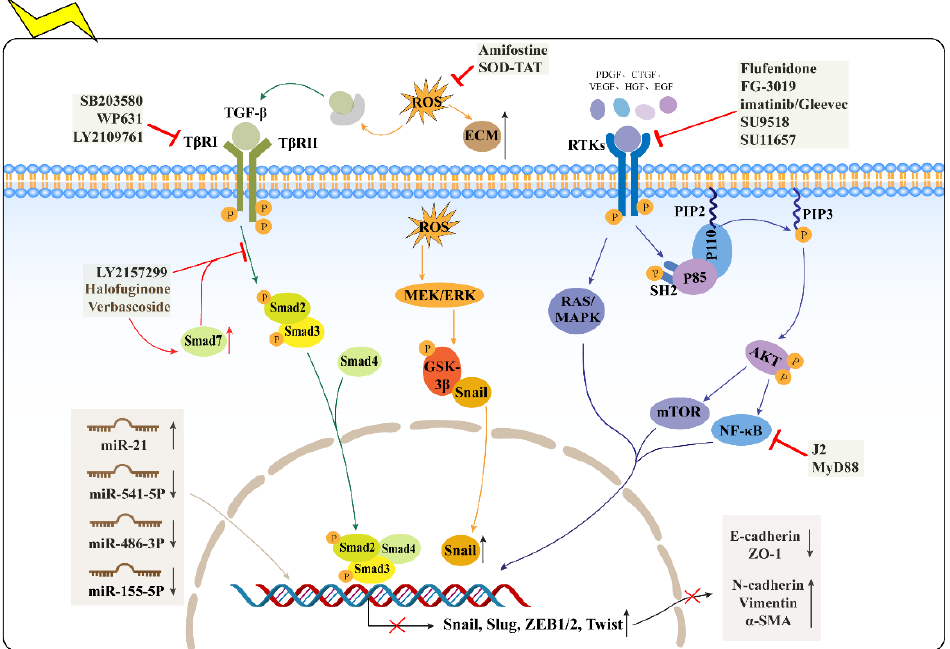
Figure 2. Signaling pathways and targets of EMT, and its therapeutic approach in RIPF. ROS, TGF- β signaling pathway, growth factors and MicroRNA are promising targets for therapeutic and developmental applications in RIPF, and their targeted inhibitors have potent inhibitory effects on IR-induced EMT in AT2 cells, respectively, inhibiting further development of RIPF. (TGF- β - Transforming growth factor β, TβR1 -TGF- β type I receptor, TβR2 -TGF- β type II receptor, ROS - Reactive oxygen species, RTKs- receptor tyrosine kinases, PIP2-phosphatidylinositol-4,5-biphosphate, PIP3-phosphatidylinositol triphosphate, α -SMA- α -smooth muscle actin). All arrows indicate the transduction process and protein changes in the EMT signaling pathway, and the red crosses indicate that the above inhibitors can ultimately suppress the change of EMT-related marker proteins by inhibiting the elevation of transcription factors, ultimately inhibiting IR-induced EMT in AT2.